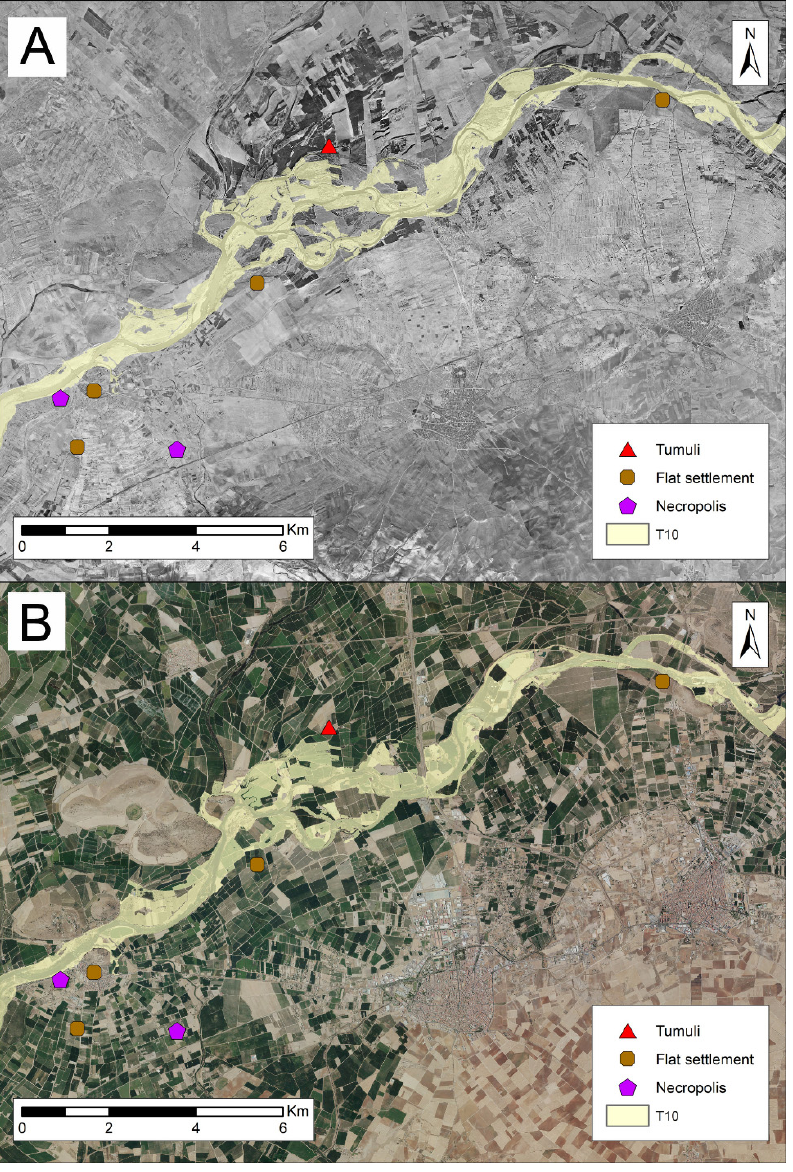
Figure 20. Cartography resulting from superimposing the T10 shading on a photogram of the AMS (B) (1956–1957) ( A ) and a photogram of the most recent PNOA ( B ) to observe the impact that the execution of the Badajoz Plan had on the course of the river.